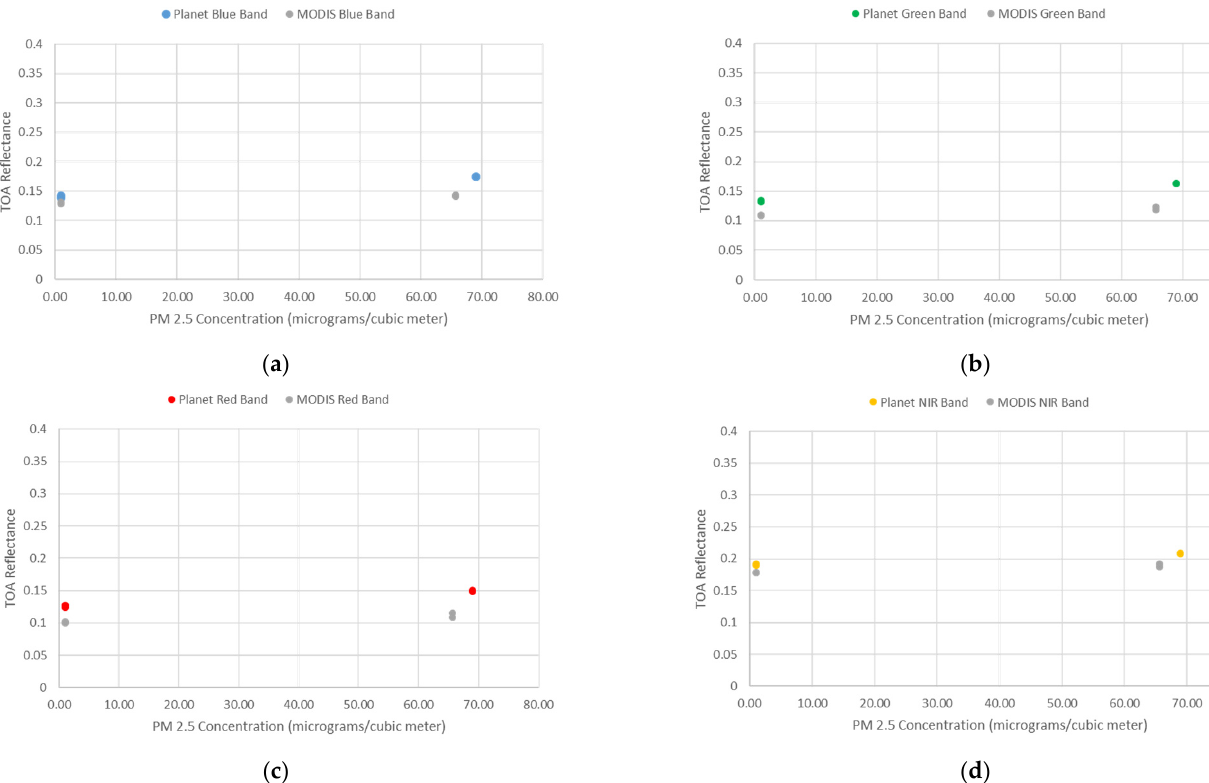
Figure A6. Data points from Figure 6 (SPOKANE—AUGUSTA AVE PM 2.5 station) showing the more pronounced increase in TOA reflectance for PlanetScope on the higher PM 2.5 day (8/14/2018) when the PlanetScope reflectance values are averaged over the same spatial area as the MODIS pixels (i.e., 2500 × 2500 m and 5000 × 5000 m centered around the PM 2.5 station). While there is a slight increase in TOA reflectance on the high PM 2.5 day, this increase is more pronounced for data isolated at the Fresno sites as illustrated in Figure 7.